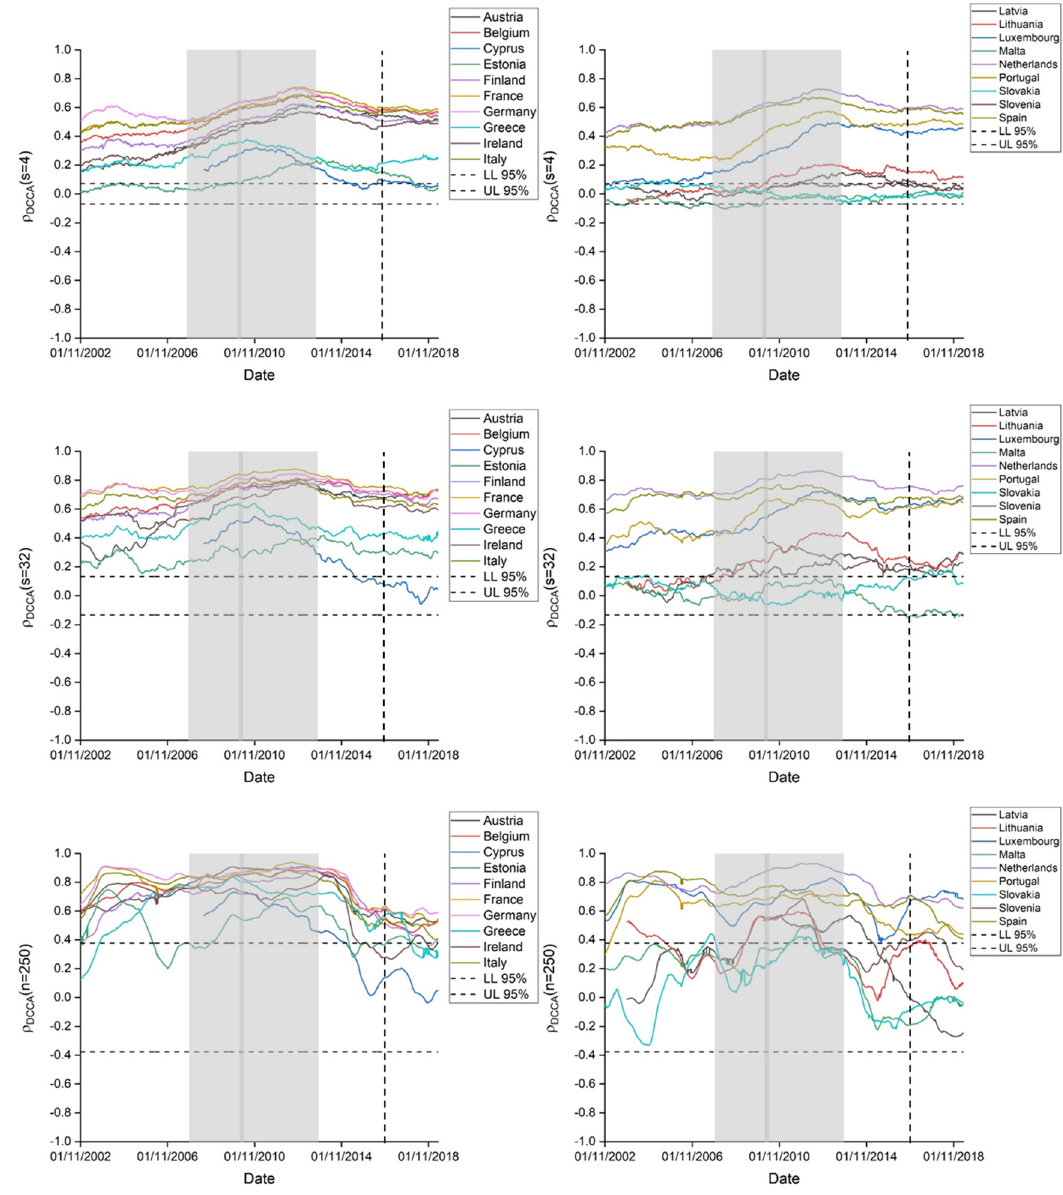
Figure 3. Evolution of ρ DCCA between Eurozone stock markets and the USA (time scales of 4, 32, and 250 days and window size w = 1000). LL and UL are, respectively, the lower and upper limits of the confidence interval. Shaded areas represent the global financial crisis and the Eurozone debt crisis. The vertical dashed line refers to the moment of the Brexit referendum.